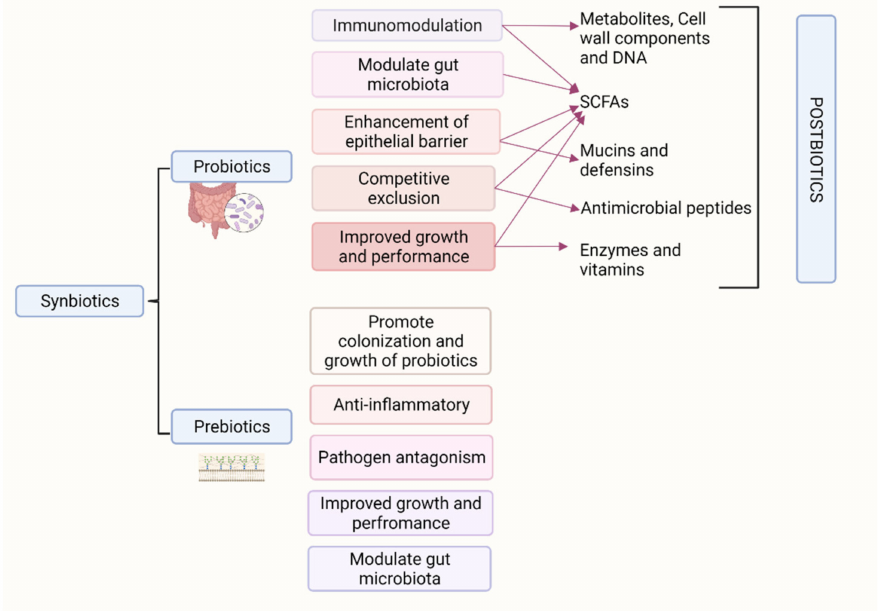
Figure 5. Synbiotics are essentially a combination of probiotics and prebiotics where the probiotic component is specifically fermentable by the prebiotic component and thus helps in establishing a stable population in the host gut. Created with Biorender.com (28 April